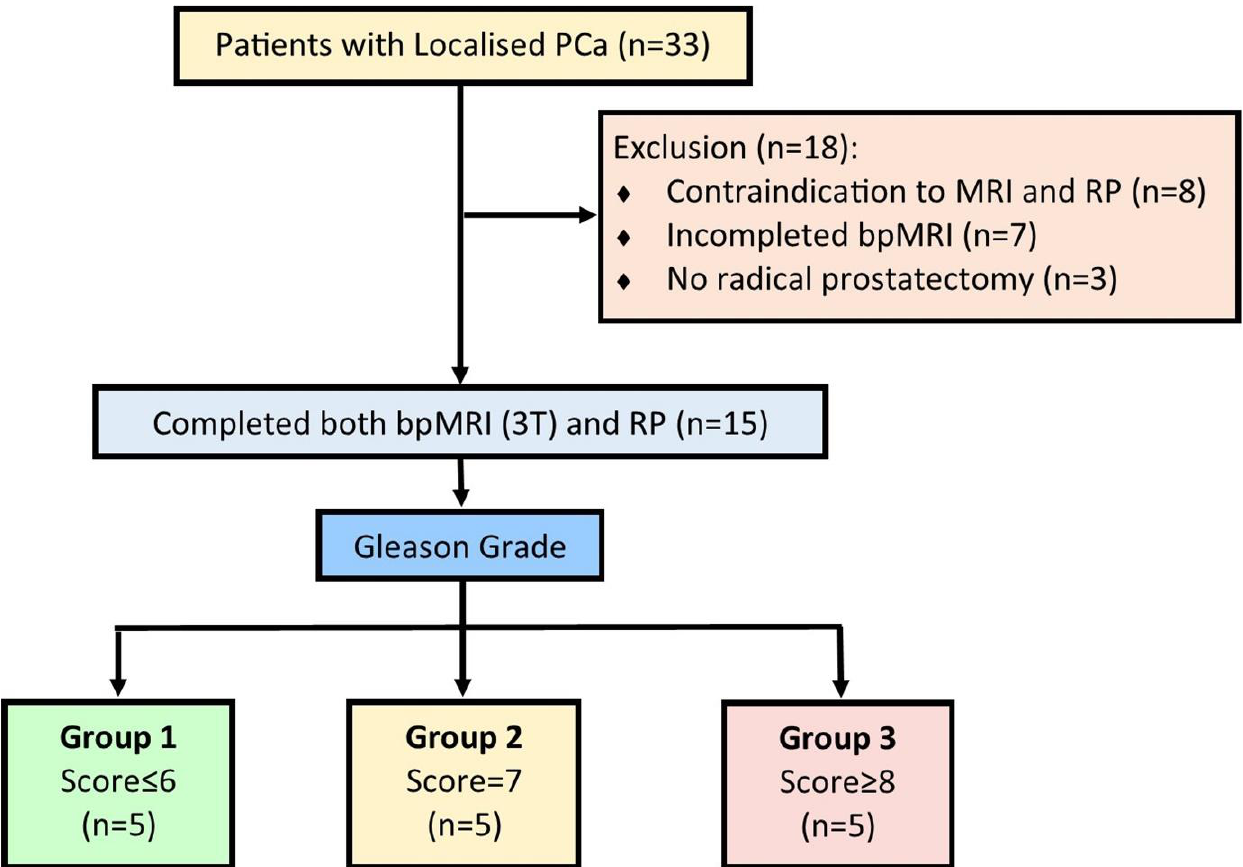
Figure 2. Exclusion and inclusion criteria for the prospective study.